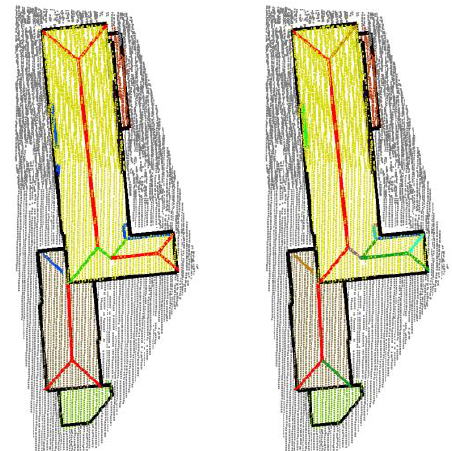
connected one-sided hip roofs, the three green intersection lines are extracted based on the plane equations of the segments. Additional lines between two segments which belong to different groups are colored in blue. The black lines are derived from the boundary detection.